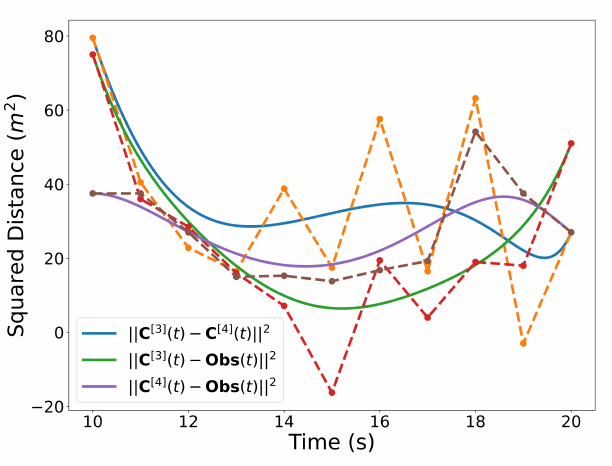
Figure 16. Squared acceleration of the trajectories C [ 3 ] ( t ) and C [ 4 ] ( t ) with corresponding convex hulls.